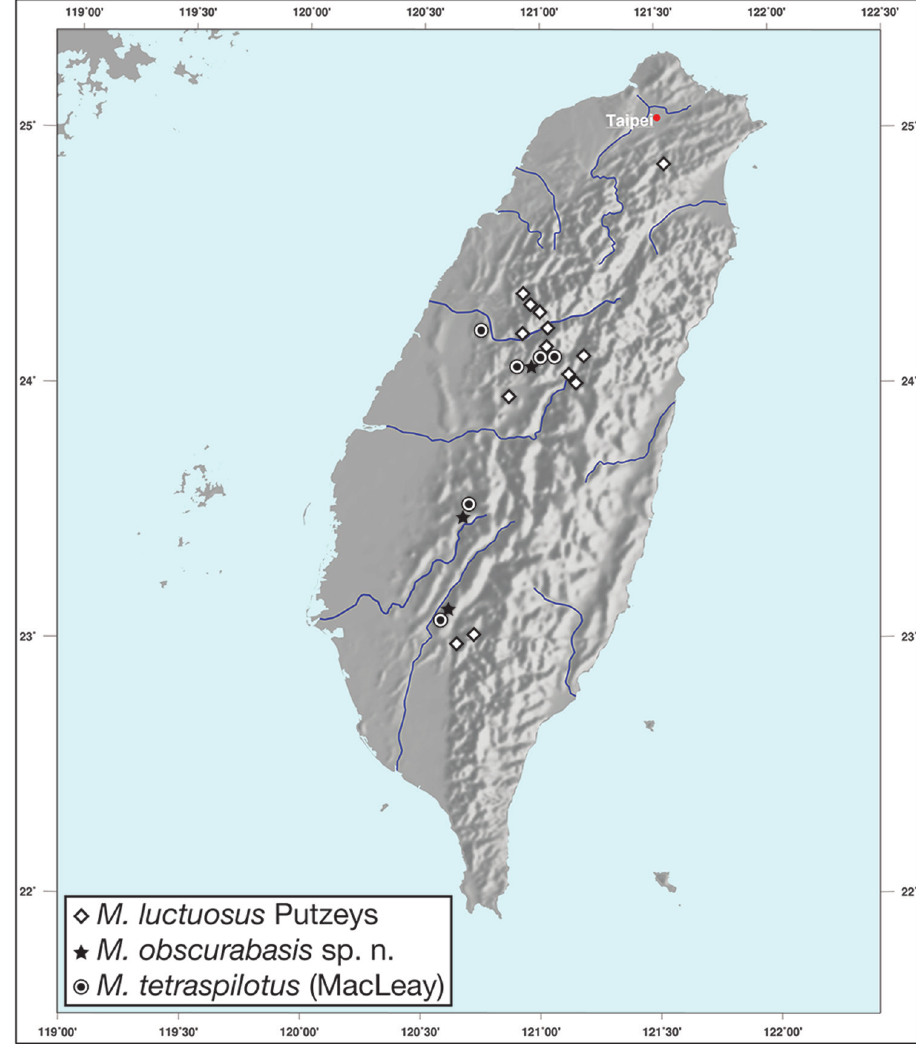
Figure 103. Map showing known localities for species of the genus Mochtherus Schmidt-Goebel, in